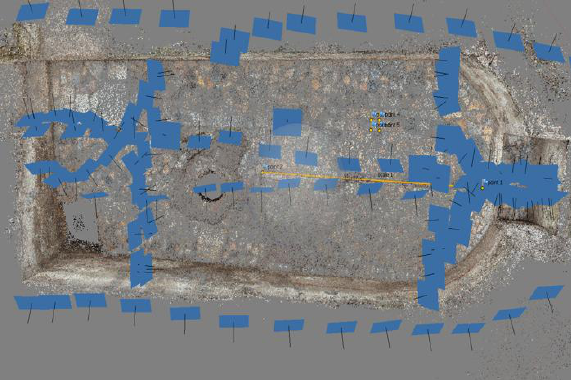
Fig. 5. Photogrammetric Camera